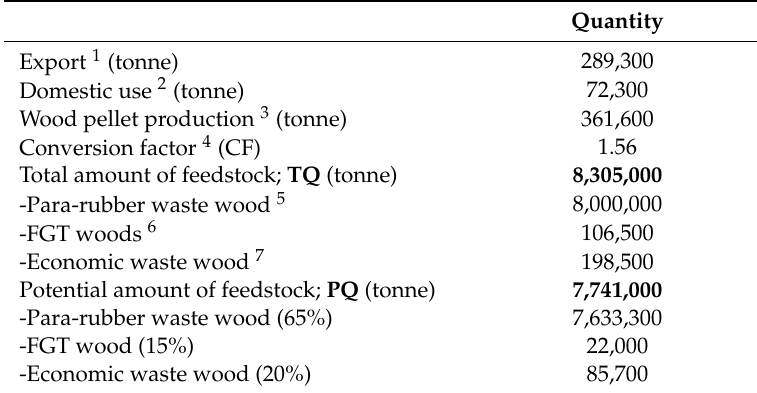
Table 6. Evaluating feedstock for wood pellet production in 2018.